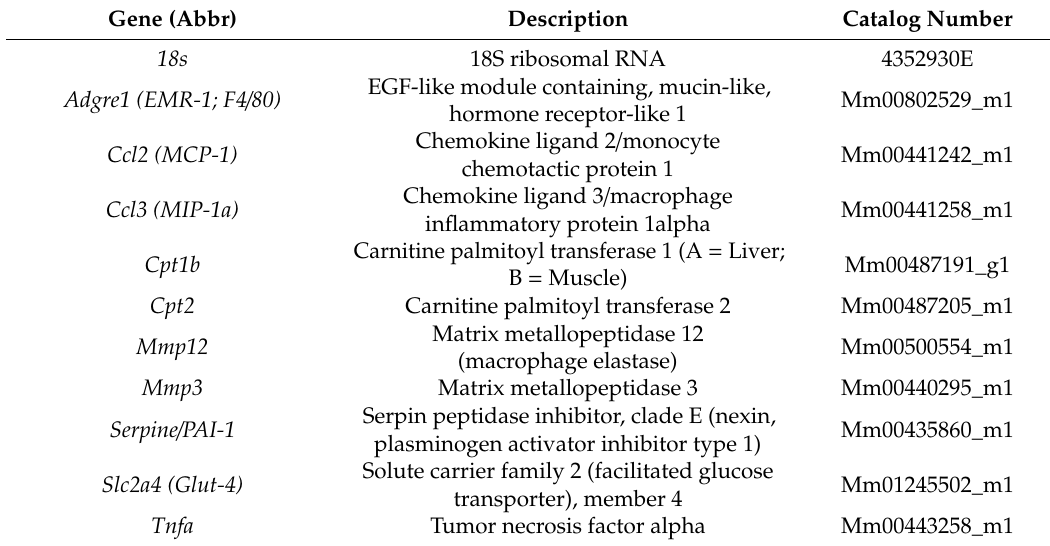
Table 1. Primers used in the